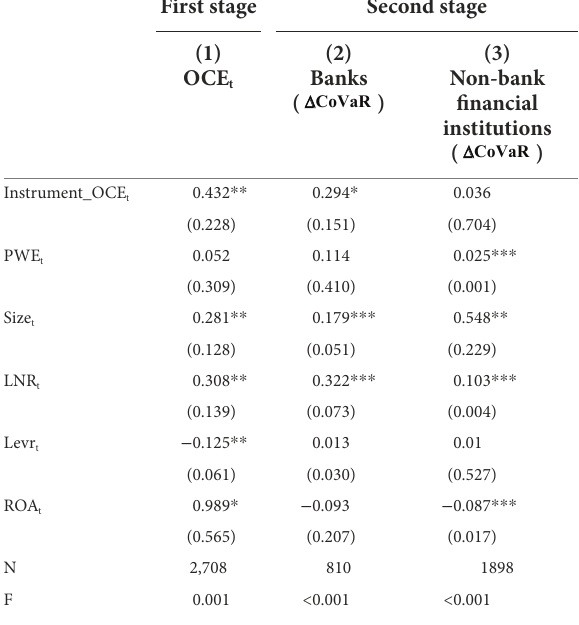
TABLE 4 Regression analysis (2-SLS